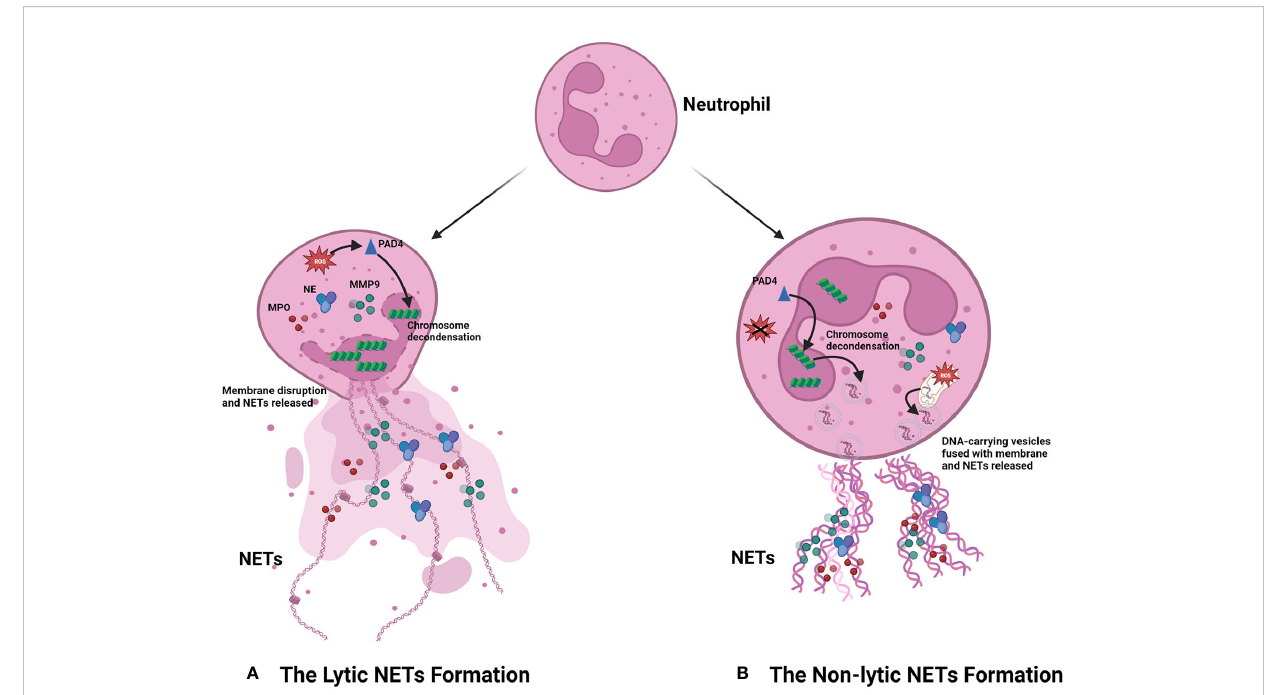
FIGURE 1 Progression of NET formation. When neutrophils are stimulated by stimulus, they can produce NETs in two main ways according to the different destinies. (A) The lytic NET formation. When stimuli including LPS, PMA, and IL-8 bind to the receptors of neutrophils, NADPH-oxidase is active, which can increase the level of ROS. Then, the increased ROS promotes chromosome decondensation by activating PAD4. The DNA derived from the chromosome is decorated with granule proteins and forms NETs, which are released from the dead neutrophil. (B) The non-lytic NET formation. The stimulus including damage-associated molecular patterns (DAMPs), bacteria, and injury can promote NET formation in neutrophils by forming vesicles. Different from the destiny of neutrophils in the lytic NET formation, these neutrophils still preserve intact membranes and the phagocytic function. Notably, the DNA in NETs derived from the chromosome of the nucleus is ROS-independent; however, the formation of NETs comprising mitochondrial DNA is